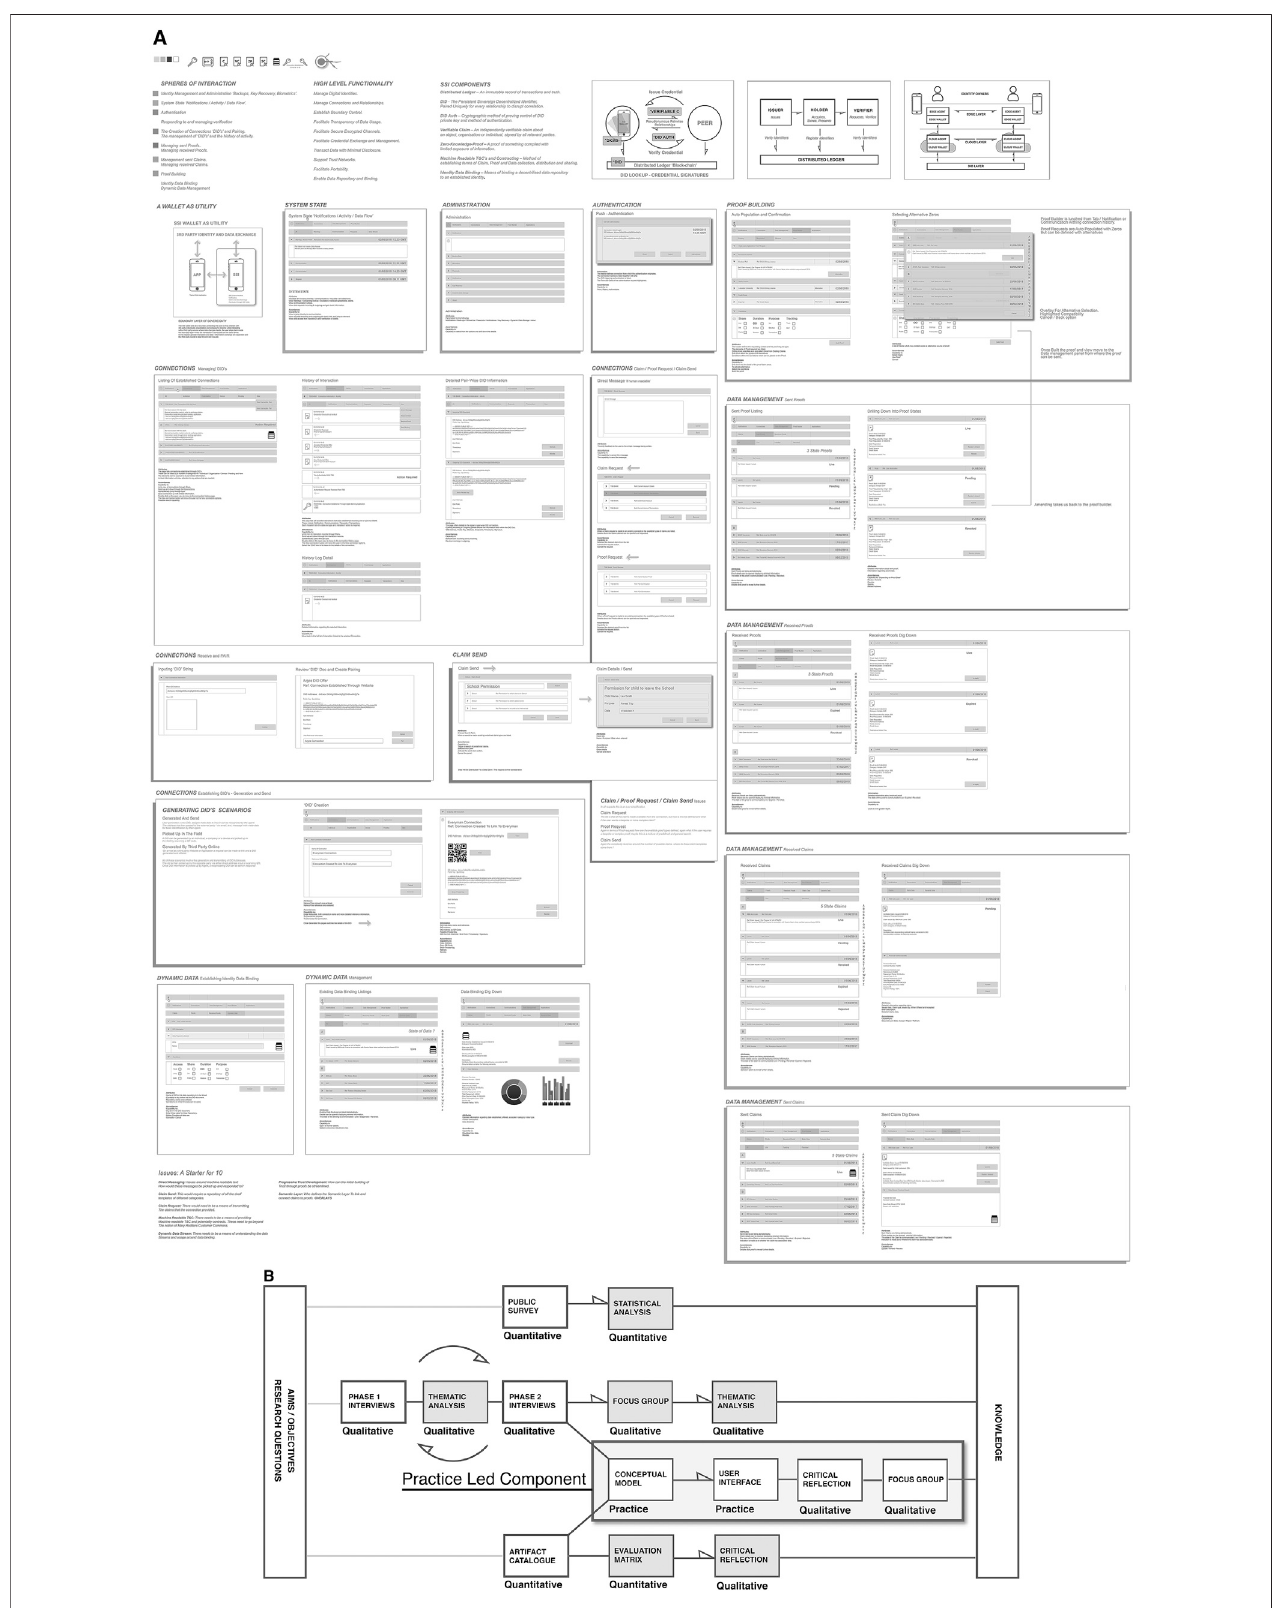
FIGURE 3 | (A) Initial User Interface and (B) All component parts of the wider research study. The highlighted section represents the practice-led component described within this paper.